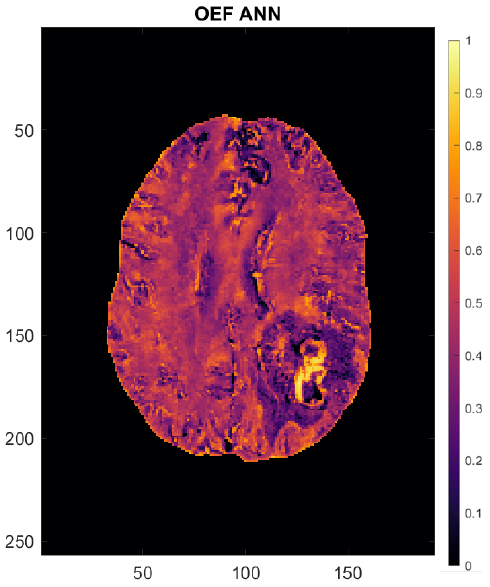
Figure 3. Oxygen extraction fraction (OEF) map of a 54-year-old female patient with left occipito- temporal glioblastoma. Axes are in mm. The scale to the right of the image indicates OEF (e.g., 0.5 = 50%).